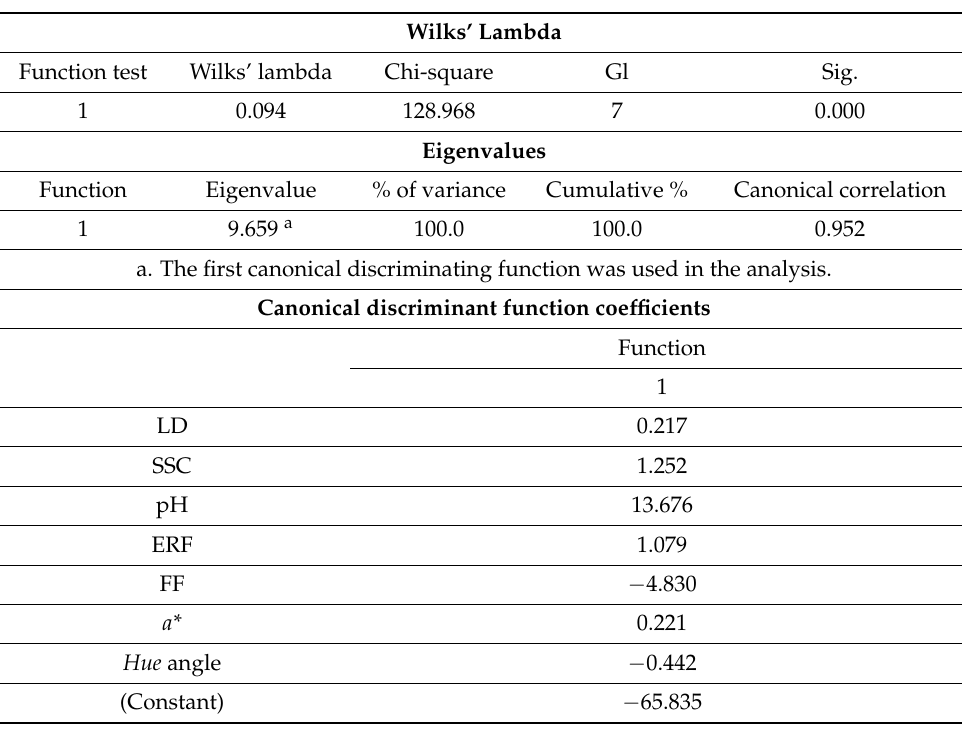
Table 3. Discriminant analysis using the whole dataset of sweet cherry Early Bigi grafted on SL 64 and Maxma 60 rootstocks. Parameters included in the function: larger diameter (LD), soluble solids content (SSC), pH, epidermis rupture force (ERF), flesh firmness (FF), a * and hue